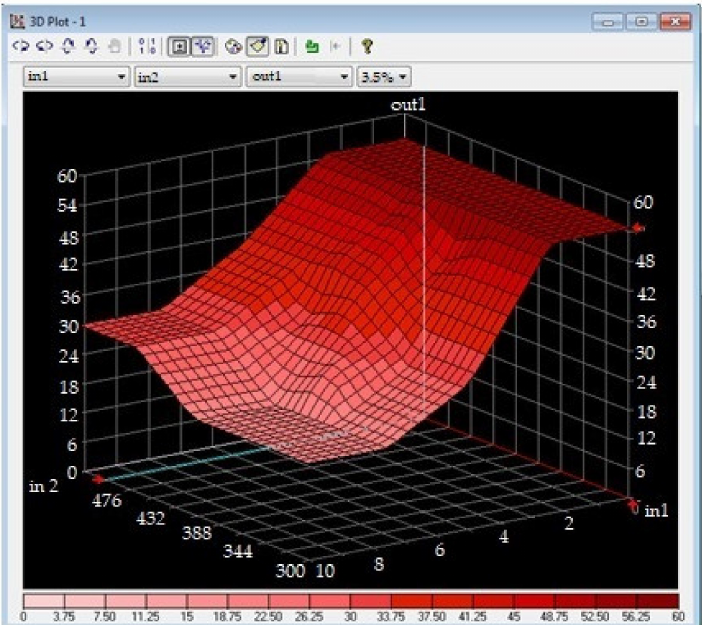
Figure 9. Surface plot out1 (optimal speed of the vehicle approaching the intersection) ( in1 (the num- ber of cars waiting at the intersection), and in2 (the vehicle’s distance to the start of the intersection)).